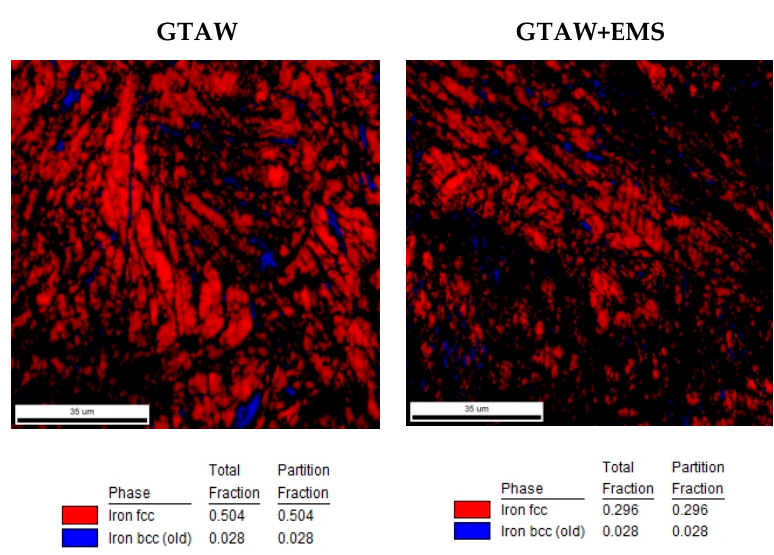
Figure 16. The EBSD analysis of the cross-section close to the rupture of the notched tensile specimens.